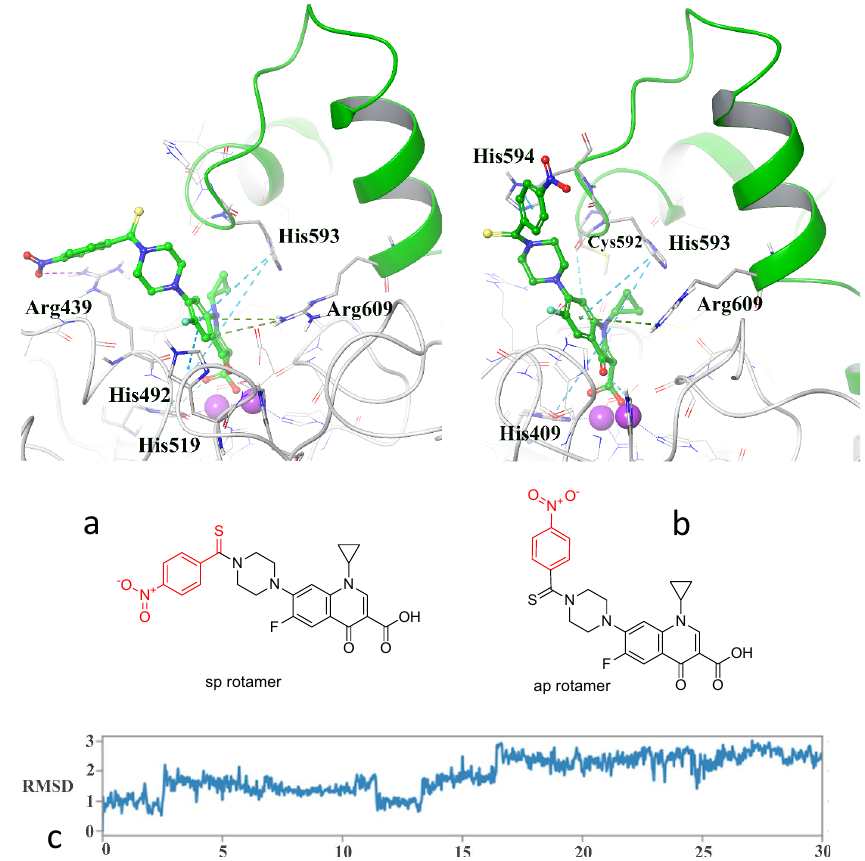
Figure 9. Two different configurations of 4-nitro phenyl thioamide moiety of compound 3n from the beginning of MD to the 16.56 ns ( a ) and from the time at 16.56 ns to the end of the MD simulation time ( b ). The RMSD of compound 3n during the whole simulation time ( c